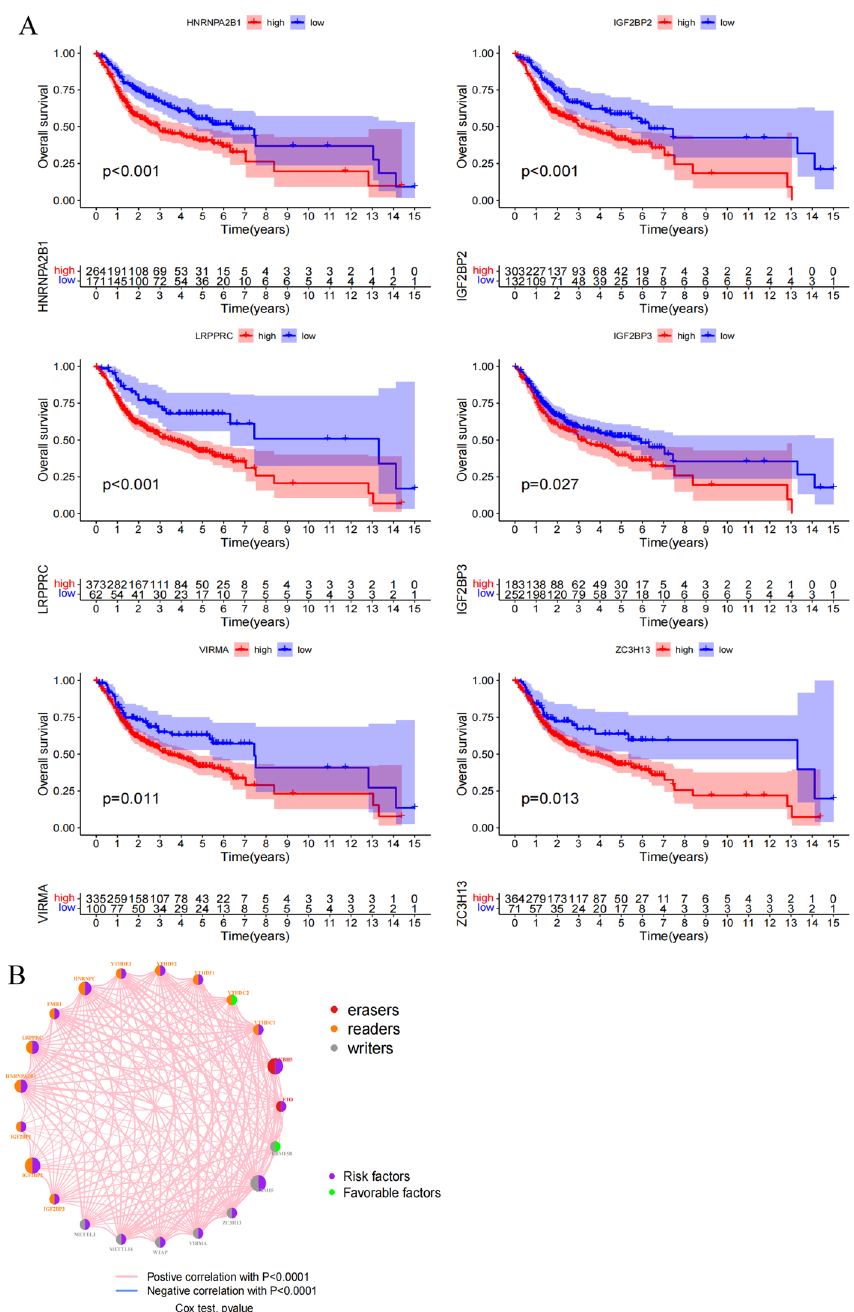
Figure 2. Correlation of m 6 A regulators with prognosis. ( A ) Kaplan–Meier survival analysis of m 6 A regulators between the high-expression group and the low-expression group using clinical information of OSCC patients in TCGA and GSE41613 cohort. High-expression, red curve; Low-expression, blue curve. P value less than 0.05 was statistically significant. ( B ) The interaction between m 6 A regulators in OSCC. Writers, readers and erasers were marked with red, orange and gray, respectively. The circle size represented the effect of each regulator on prognosis, and the range of values calculated by Cox test was p < 1e−04, p < 0.001, p < 0.01, p < 0.05 and p < 1, respectively. Green in the circle, favorable factors of prognosis; Purple in the circle, risk factors of prognosis. Curves linking regulators showed their interactions, with thickness showing the correlation strength. Positive correlation with p < 0.0001, pink curve; Negative correlation with p < 0.0001, blue curve. The figure was generated using R software (V 4.1.2, https:// www.r- proje ct.